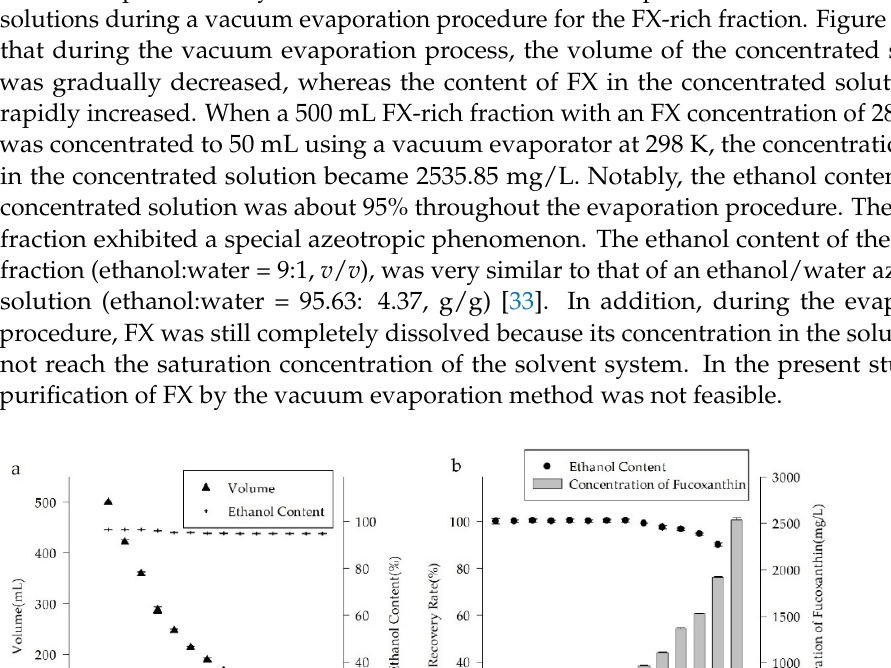
Figure 4. The variations of four key parameters during the vacuum evaporation process. ( a ) The volume and ethanol content of the concentrated solution. ( b ) The concentration and recovery rate of FX in the concentrated solution.